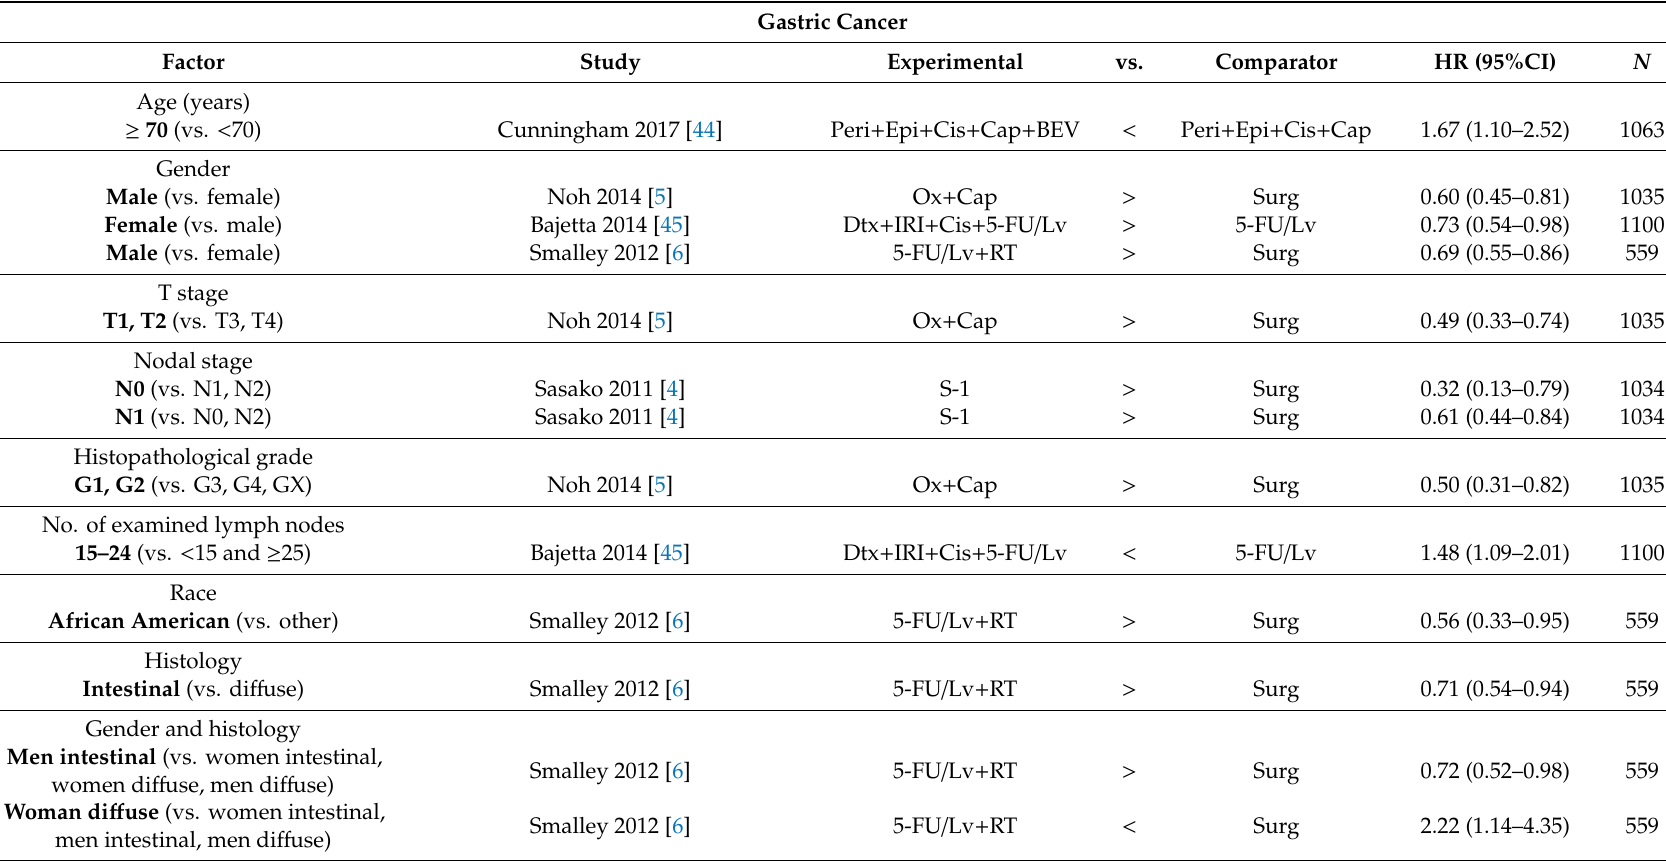
Table 3. Potentially clinically relevant predictive factors for the curative treatment of gastric cancer. Potentially clinically relevant predictive factors for OS defined as the p -value for subgroup interaction between two or more subgroups should be < 0.20 and the HR of one of the subgroups was statistically significant ( p < 0.05). The greater than ( > ) or smaller than ( < ) symbols indicate which specific treatment showed a significant survival benefit over the other treatment in a specific patient subgroup highlighted in black. All studies investigated adjuvant therapy after surgery except for Cunningham 2017 and the MAGIC